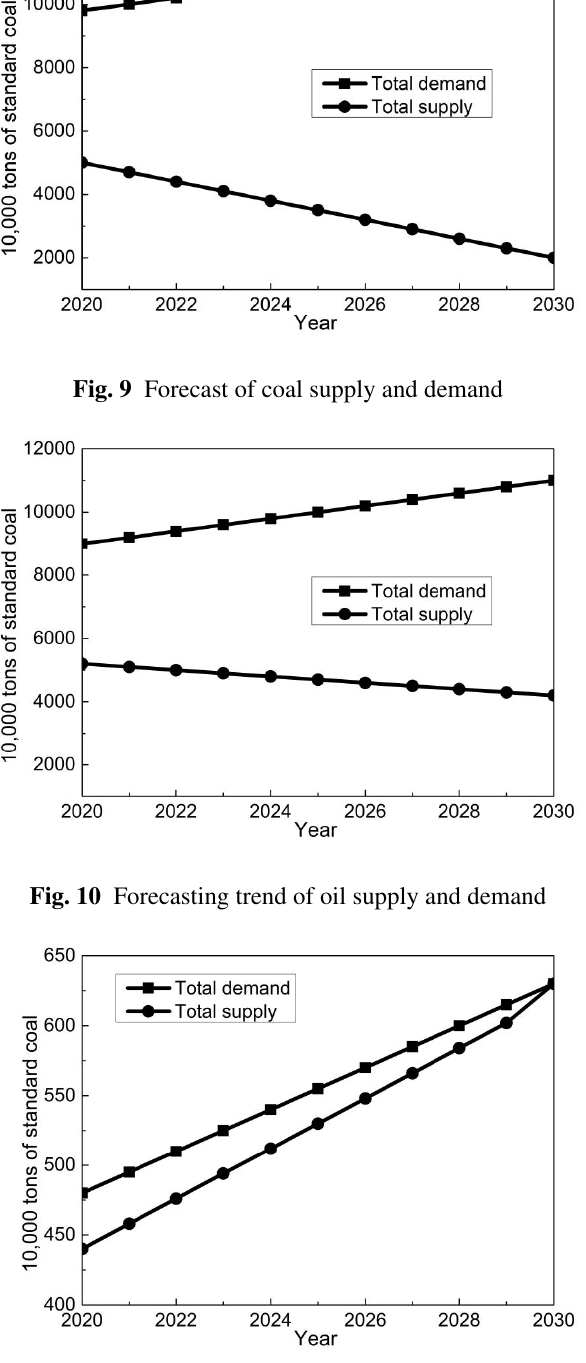
Fig. 11 Forecast of natural gas supply and